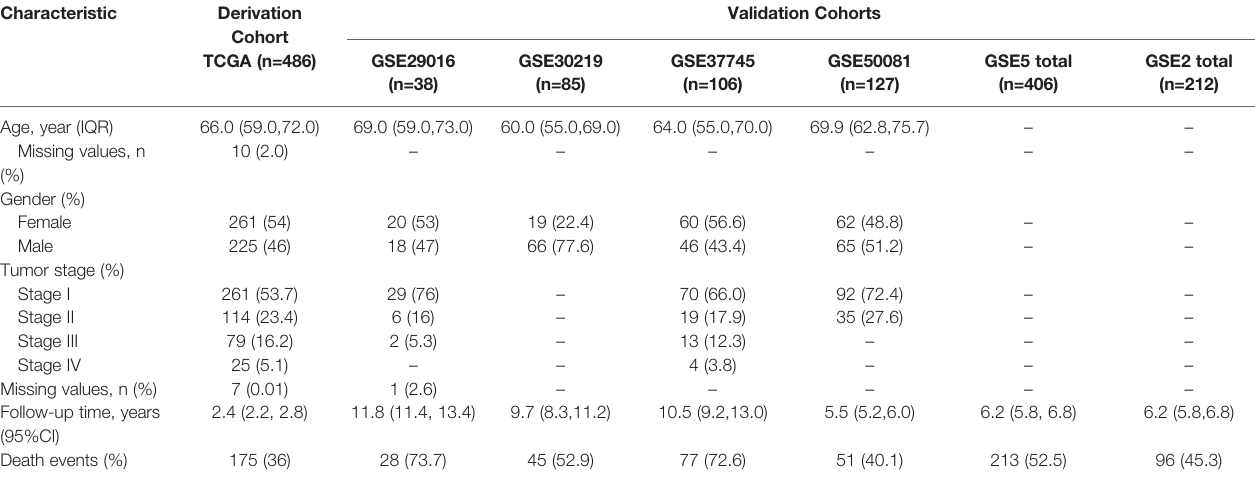
TABLE 1 | Patient